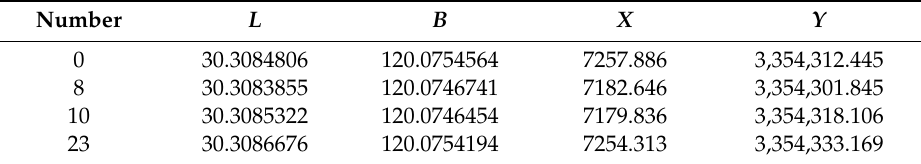
Table 2. Latitude and longitude of control points and their plane